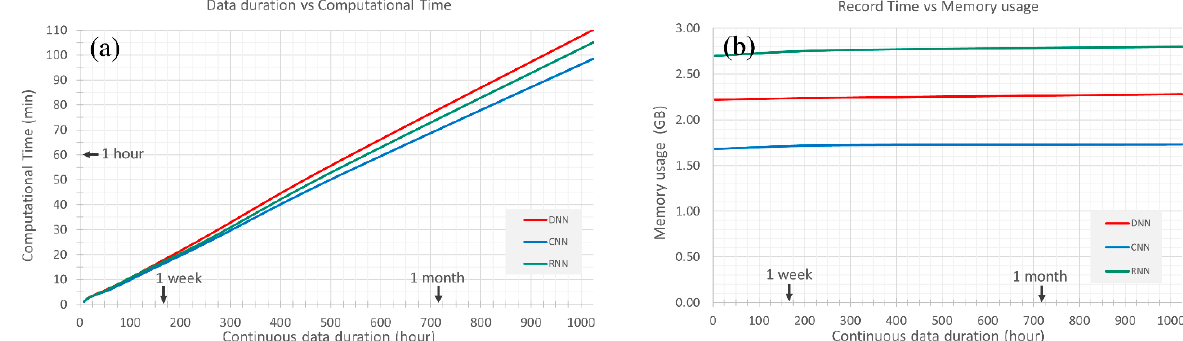
Figure 10. ( a ) The run time required by DNN (red), CNN (blue), and RNN (green) to process a seismic record 1024 h long (2.35 GB). ( b ) The memory usage required by the three networks to process the long seismic record, including the RAM usage and TensorFlow in the backend.